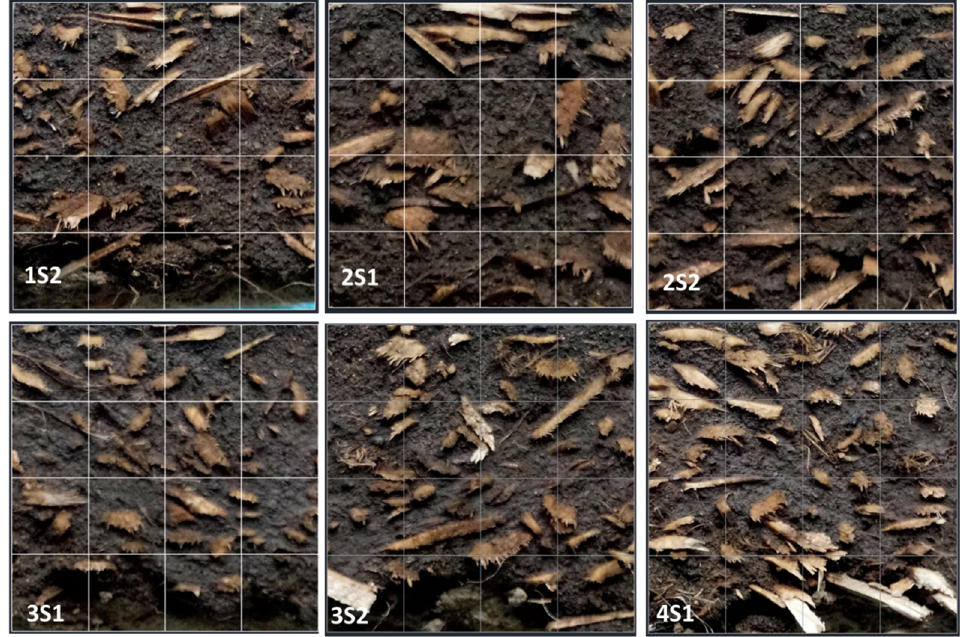
Figure 10. Cross-sections of dynamically compacted brick. The area of fibers and number of fibers were found with ImageJ in each square through binarization. The following equation was used to find the area occupied by fibers in each square.